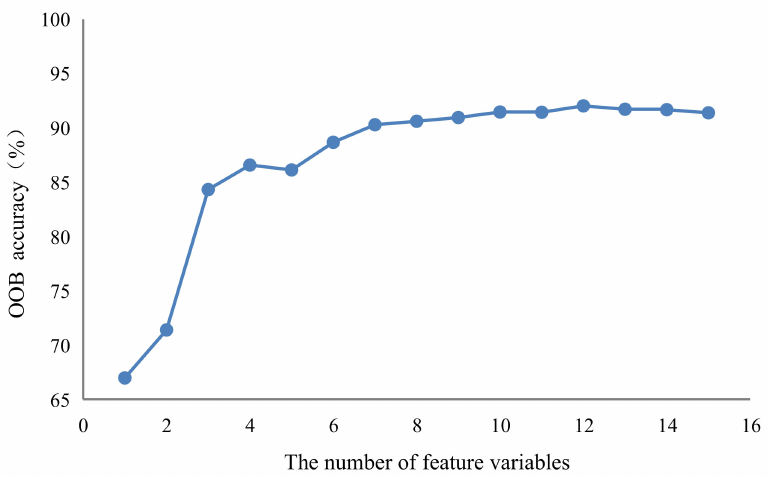
Figure 7. The relationship between the number of feature variables and out-of-bag (OOB)